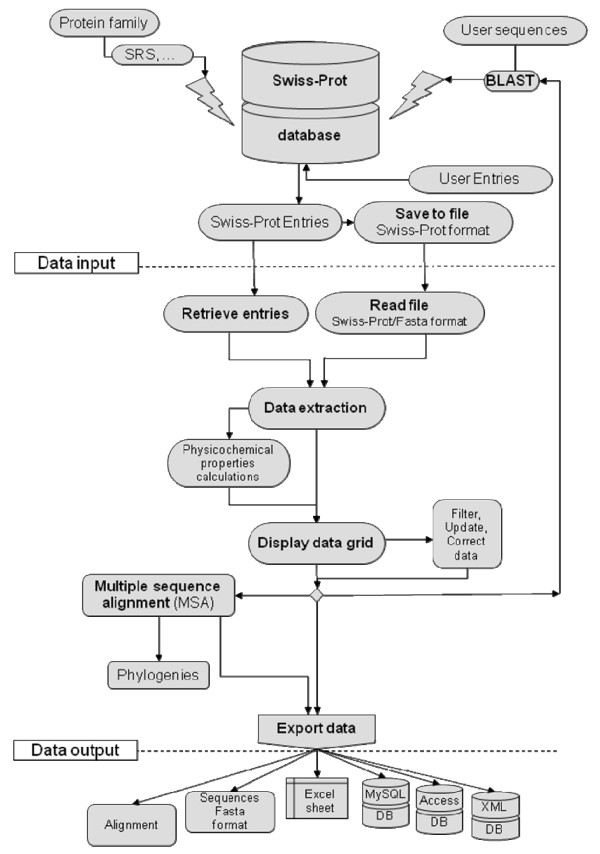
Workflow diagram.